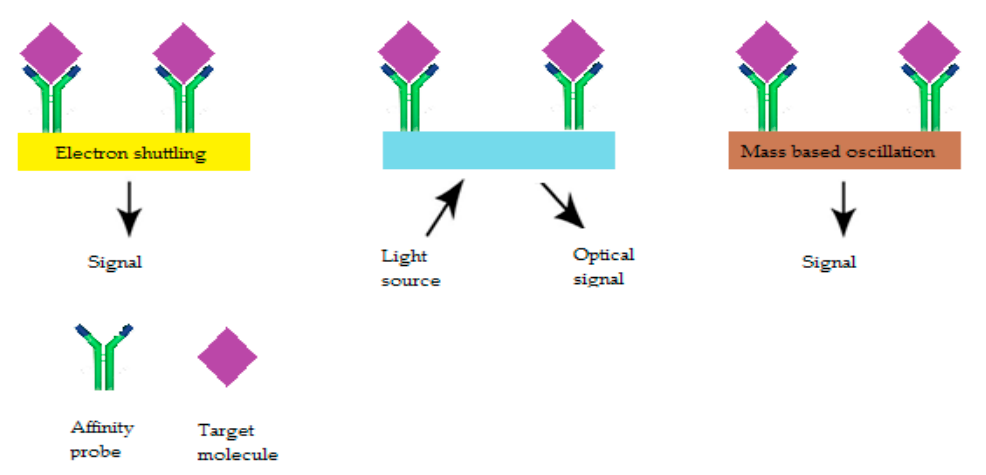
Figure 7. Type of biotransducers used in an AS [9].